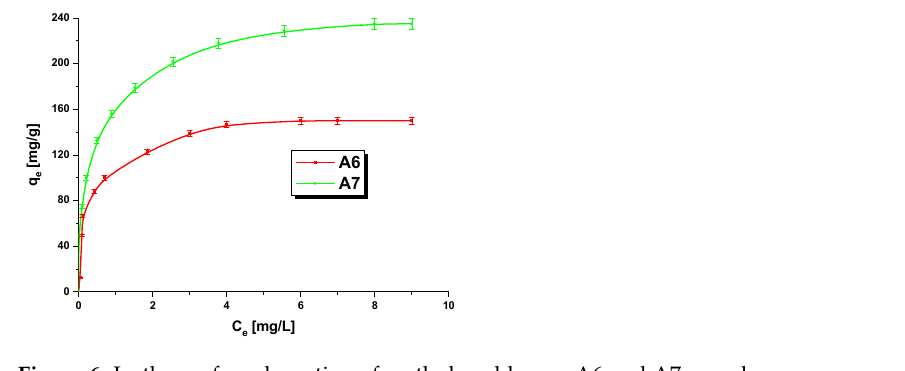
Figure 6. Isothermsfor adsorption of methylene blue on A6 and A7 samples.